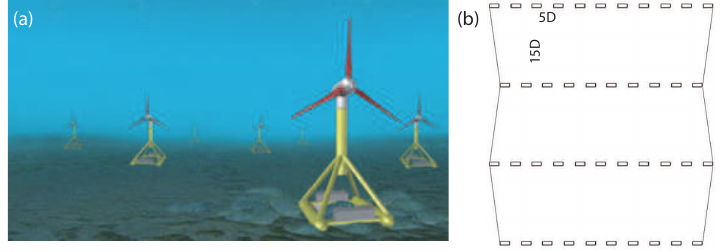
Figure 14. Proposed TEF: ( a ) view and; ( b )